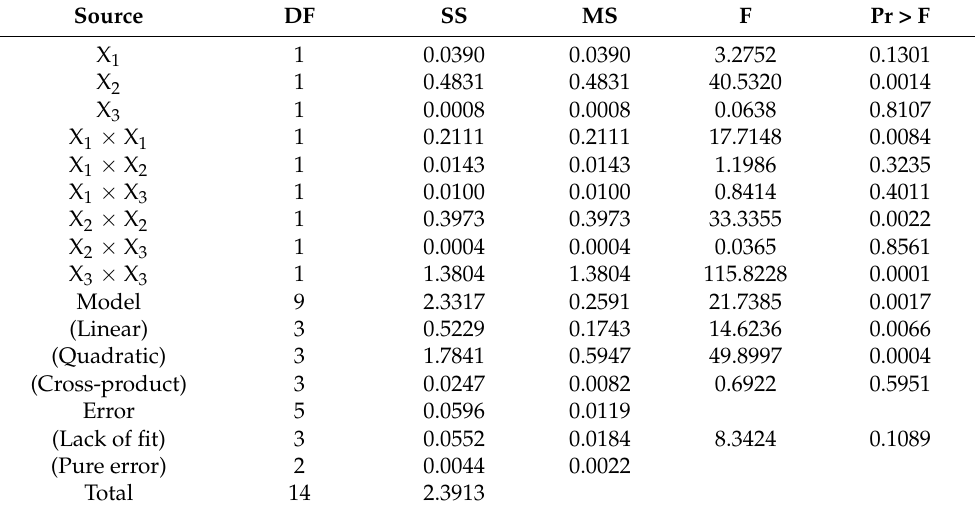
Table 3. Analysis of variance for MQR